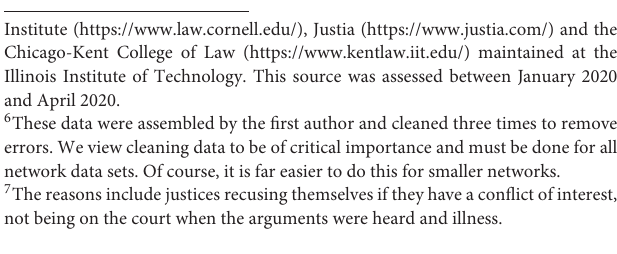
The justices who have been on this court are John G.